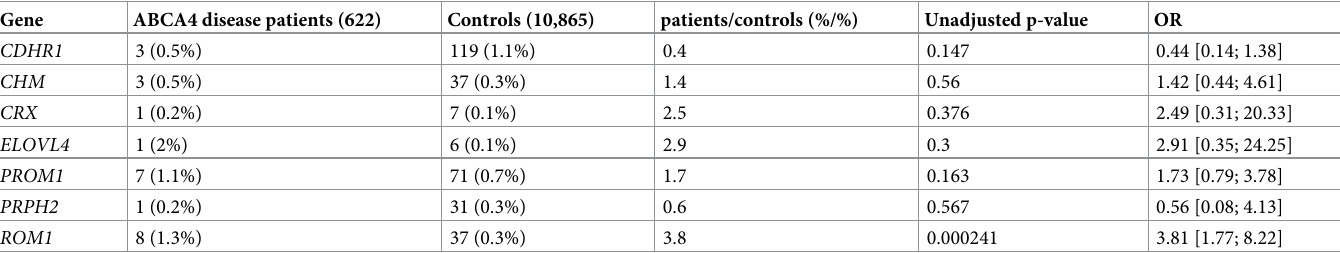
Table 2. Heterozygous individuals in ABCA4 disease and control cohort harboring variants with MAF < 0.005 and CADD score > 25, in each macular dystrophy gene CDHR1 , CHM , CRX , ELOVL4 , PROM1 , PRPH2 , and ROM1 . All comparisons were performed with the two-sided FET. Gene ABCA4 disease patients (622) Controls (10,865) patients/controls (%/%)